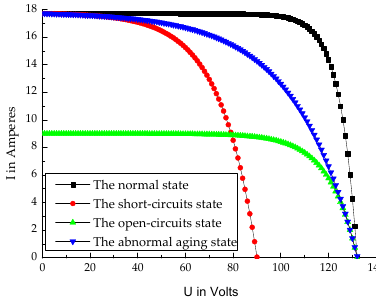
Figure 4. The V-I curves of the 3 × 2 photovoltaic array in different states.